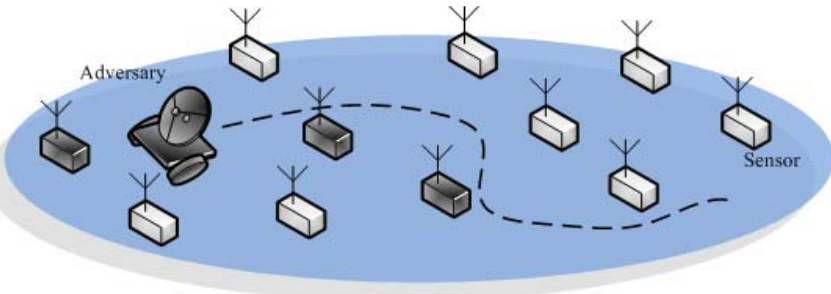
Figure 2. The adversary also roams around the sensing region and compromises the sensors. In this plot, the adversary can compromise one sensor at each round, and three sensors are compromised by the adversary after the first three rounds of a collection